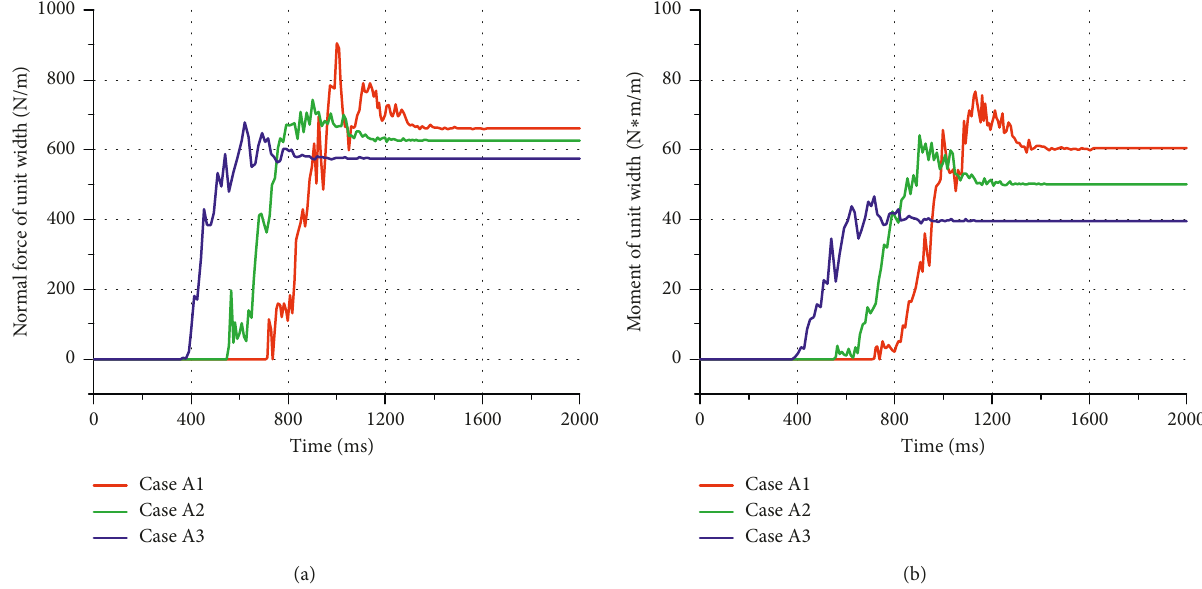
Figure 9: Time history of the impact of the granular flow on the RNB when placed at different positions: (a) time history of the unit-width normal force; (b) time history of the unit-width